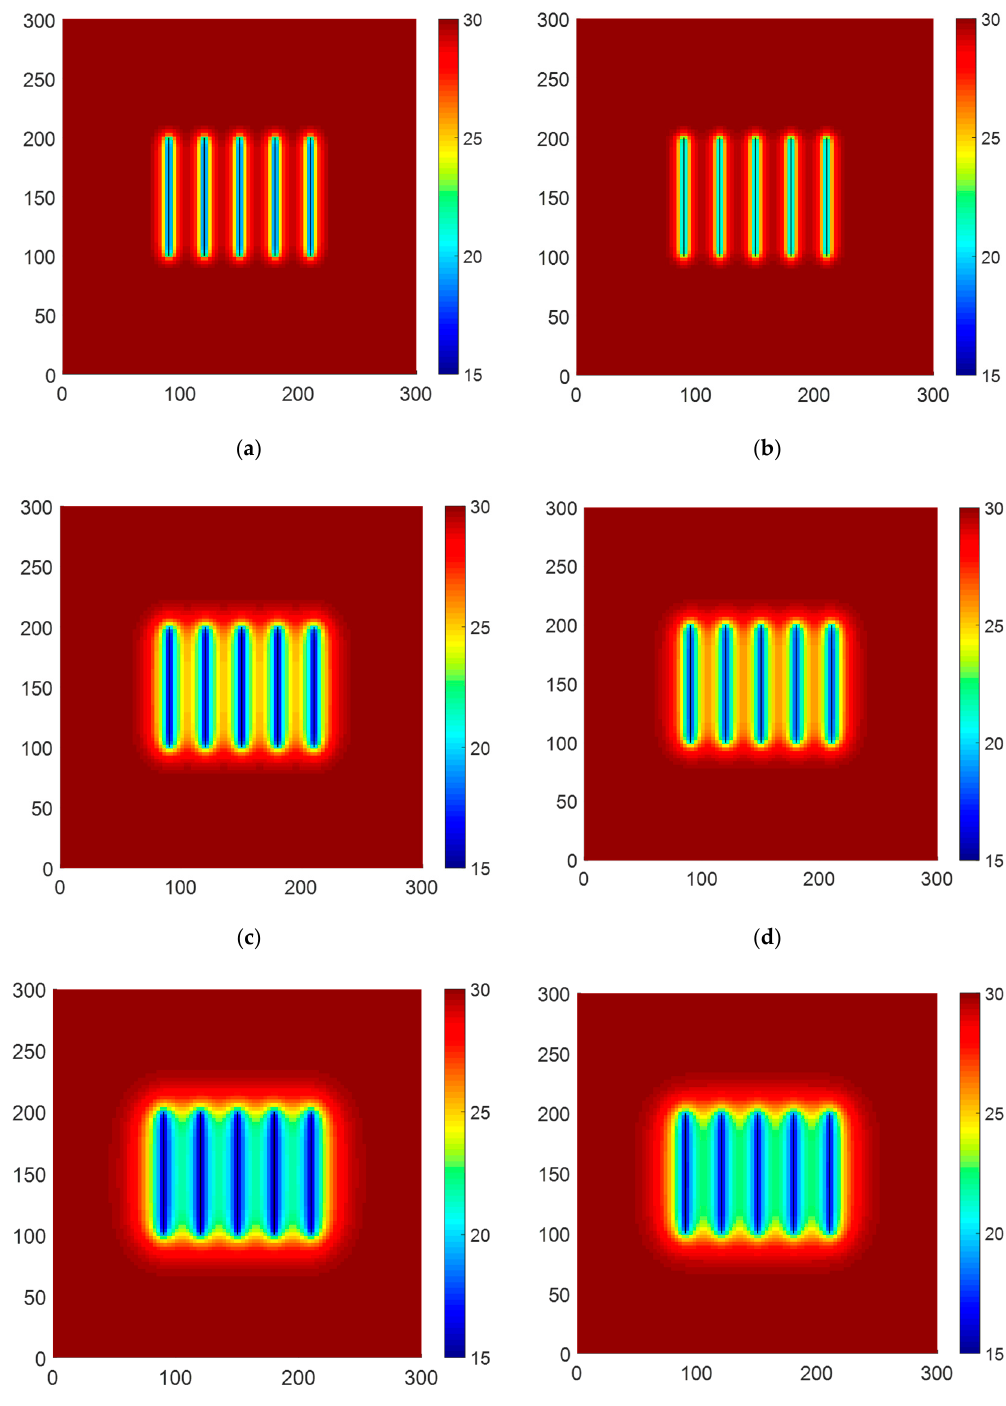
Figure 6. Formation pressure at different production times. ( a ) Pressure of production, 50d (constant conductivity). ( b ) Pressure of production, 50d (variable conductivity). ( c ) Pressure of production, 180d (constant conductivity). ( d ) Pressure of production, 180d (variable conductivity). ( e ) Pressure of production, 1y (constant conductivity). ( f ) Pressure of production, 1y (variable conductivity).